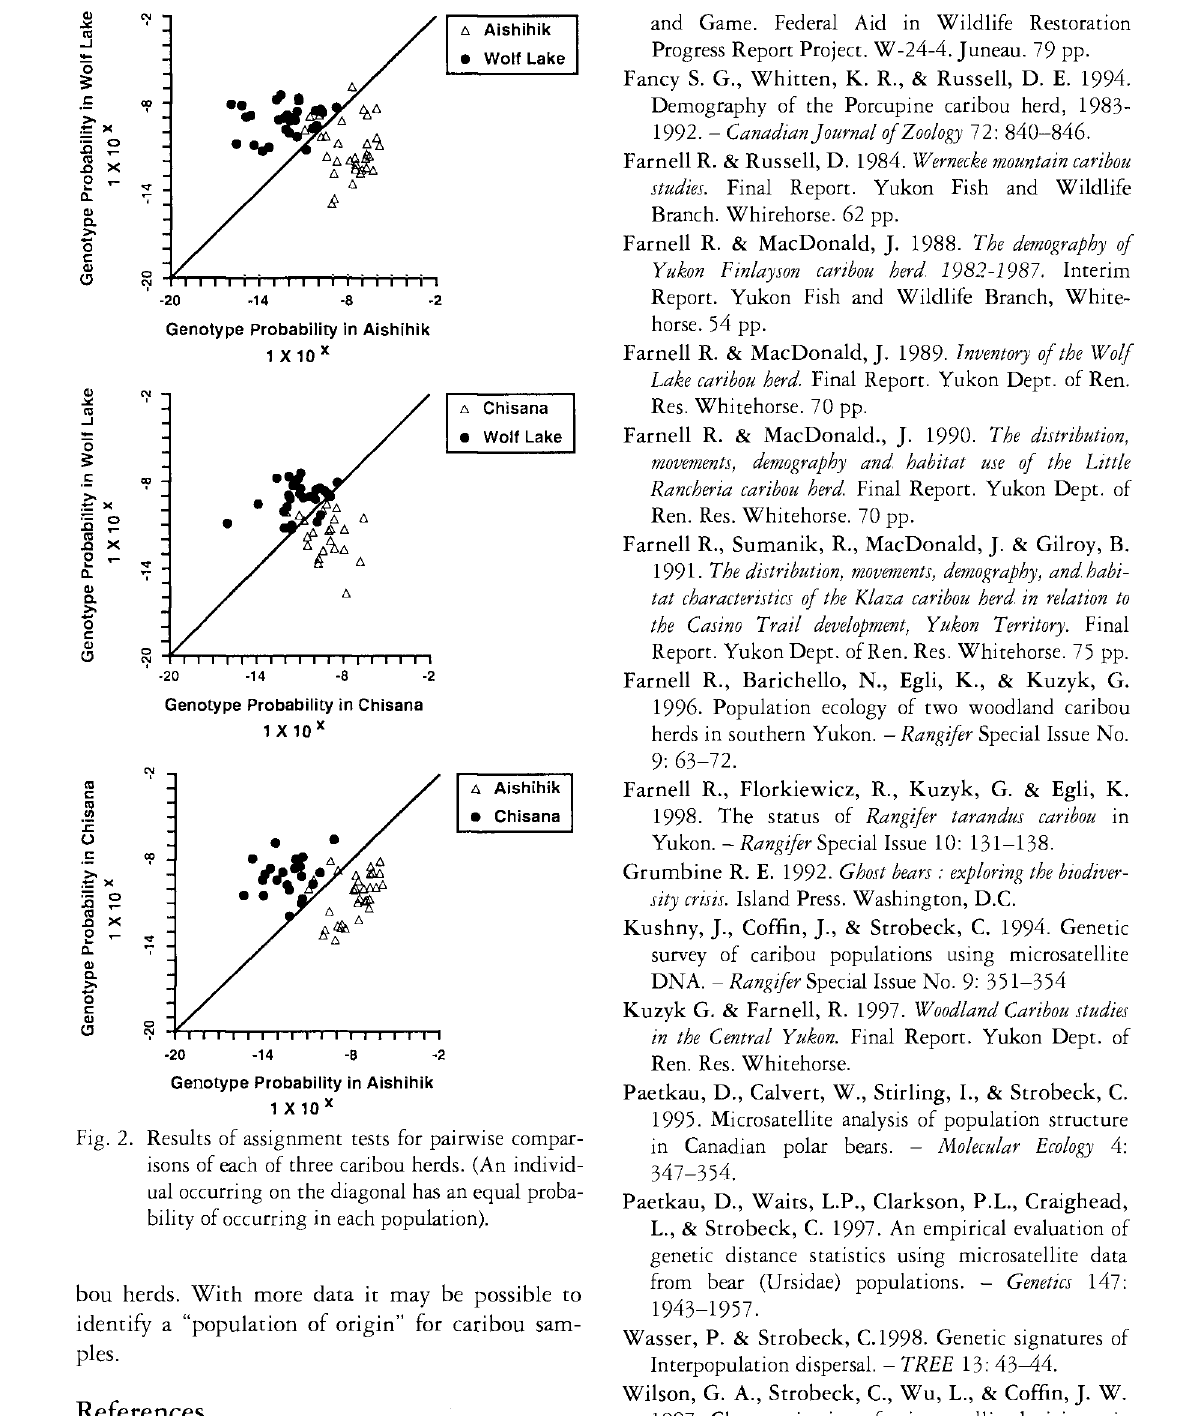
Fig. 2. Results of assignment tests for pairwise compar isons of each of three caribou herds. (An individ ual occurring on the diagonal has an equal proba bility of occurring in each population).